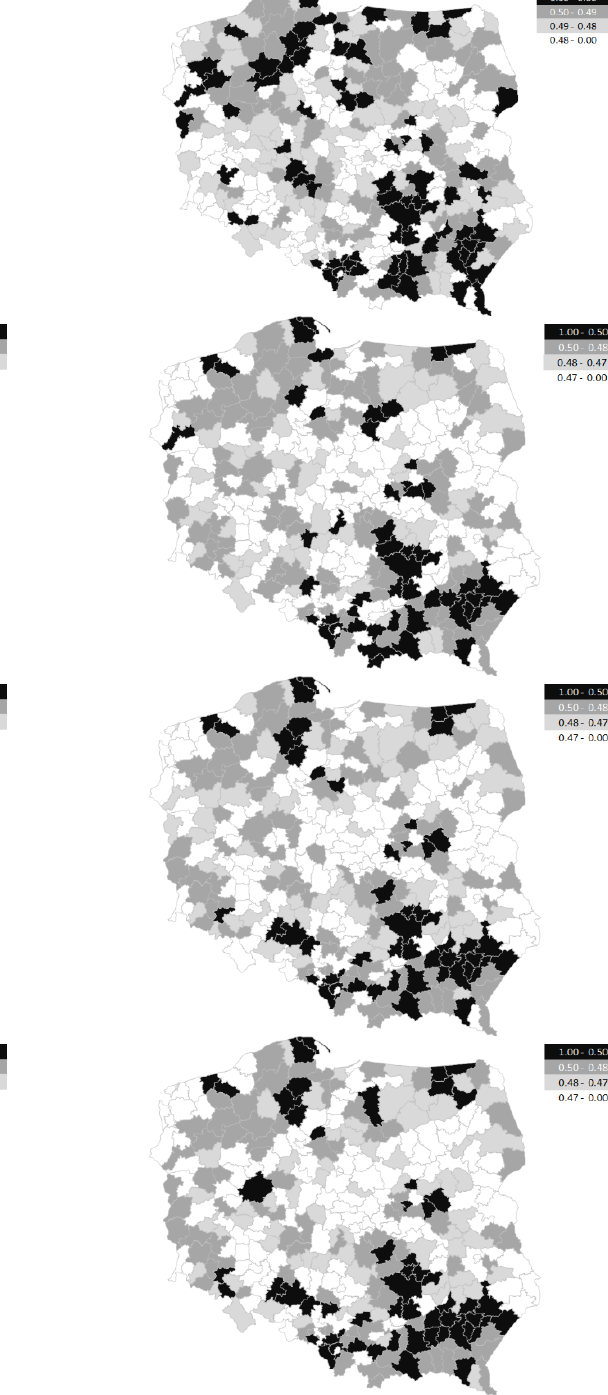
Figure 3. Spatial differentiation, waste management and green economy in districts in Poland (in 2010, 2015, 2019, and 2020). Source: own study based on the BDL CSO data. The similarity or dissimilarity of the units with respect to the main criterion exam- ined (q waste management—the best unit—Nowos ą decki district, the weakest unit Byd- goszcz, Polkowicki district; q green economy—Bielski, Kozieniecki and Wo ł owski) was expressed by the Euclidean Distance (Table 5). The distance is 0 if they are identical. The further away the objects are, the more dissimilar they are (=1). There is a greater